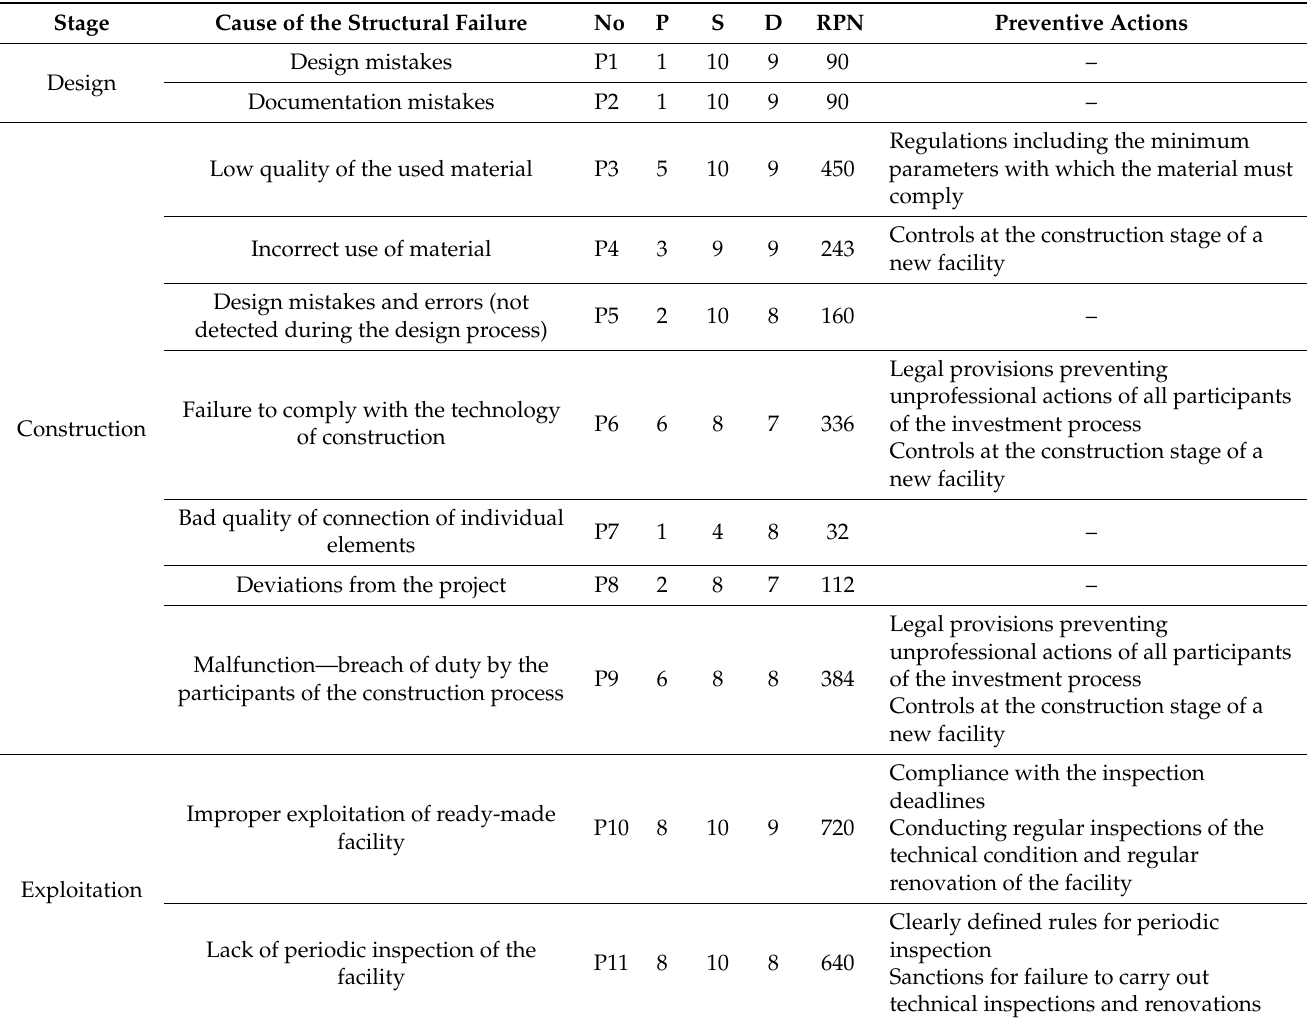
Table 2. Results of FMEA for the structural failures caused by human error (own